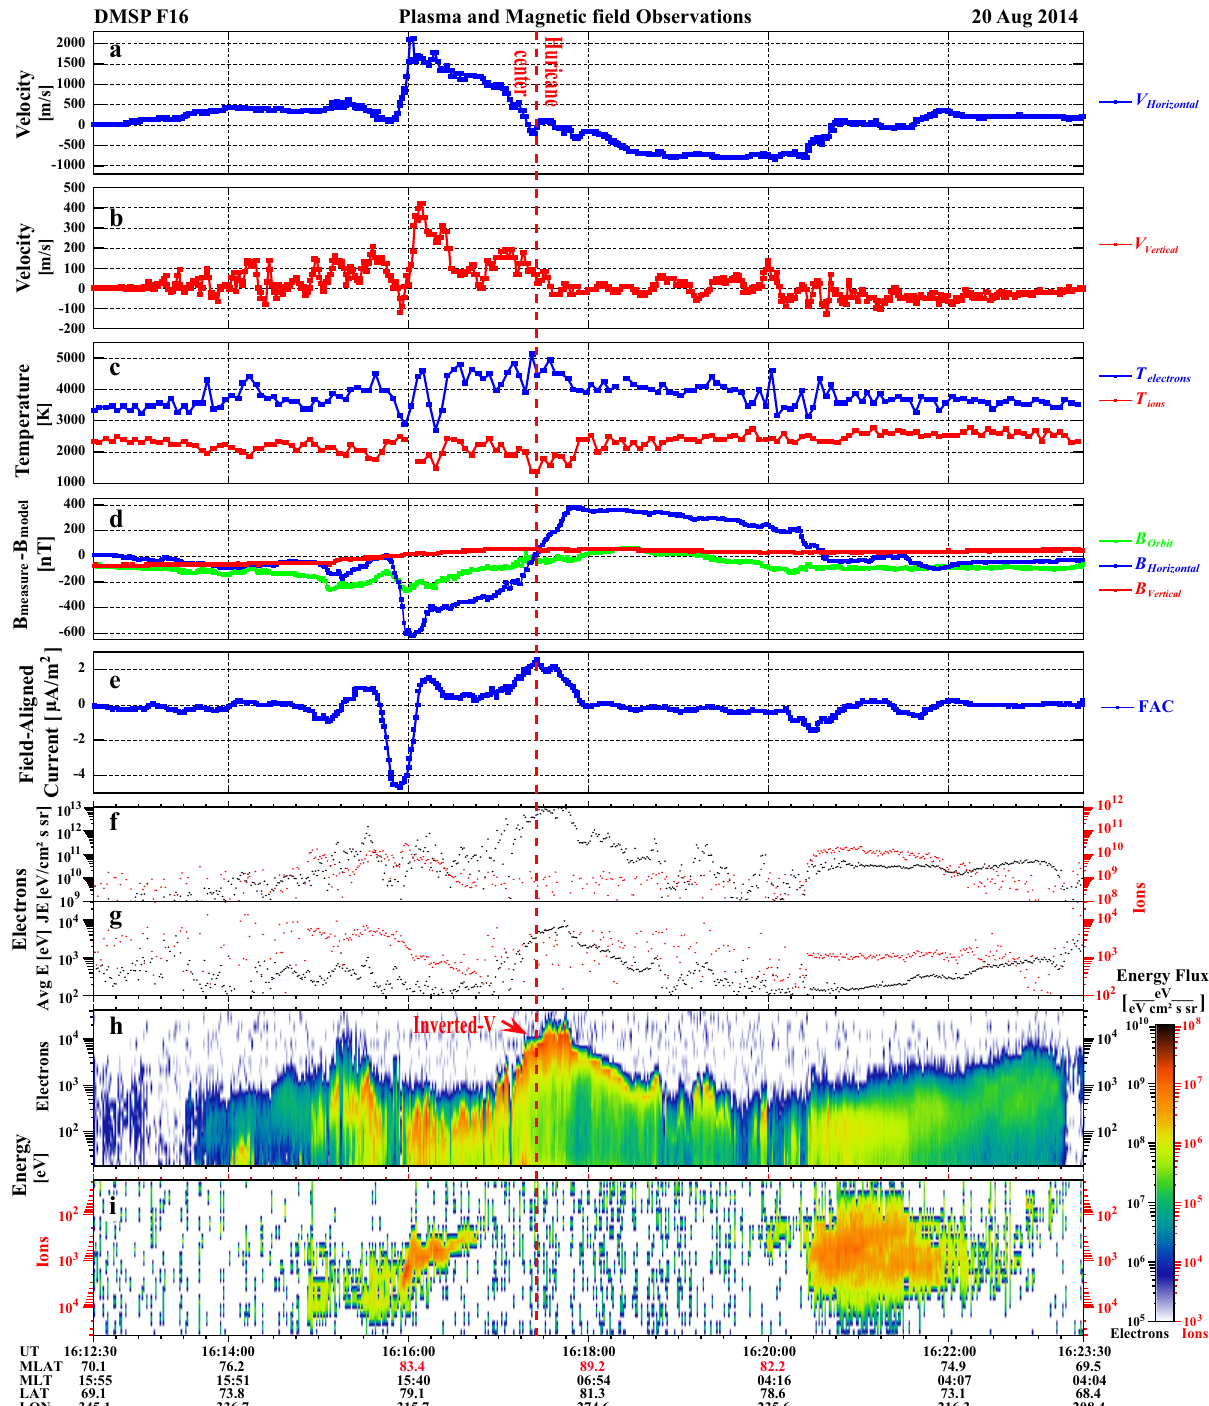
Fig. 3 The in-situ plasma and current conditions for the orbit of DMSP F16 shown in Fig. 2a. a , b The cross-track horizontal and vertical ion fl ow; c electron and ion temperature; d the three components of the measured magnetic fi eld subtracted by the modeled magnetic fi eld from the International Geomagnetic Reference Field (IGRF) model 45 ; e the calculated fi eld-aligned current; f the precipitating electron and ion total energy fl ux, JE; g the electron and ion average energy, Avg E; h the precipitating electron energy fl ux, and i the precipitating ion energy fl ux. Data in a – c are measured by SSIES, data in d , e are observed or calculated from the magnetic fi eld measurement of SSM, and data in f – i are measured by the Special Sensor for Precipitating Particles (SSJ4) instrument on board the DMSP F16